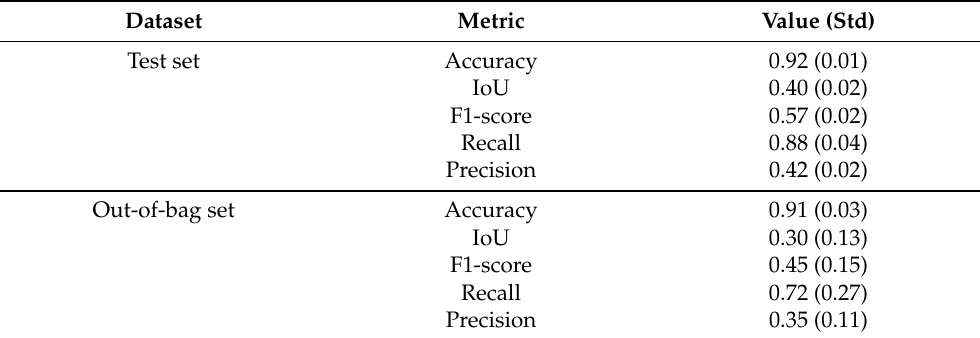
Table 2. Results shown as mean and standard deviation over all cross validation iterations for the RGB + multispectral